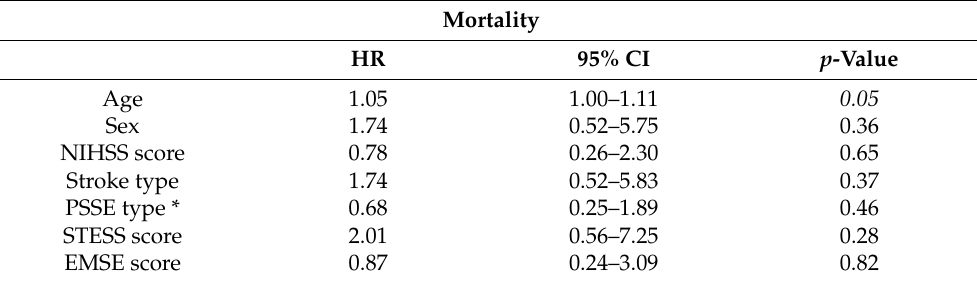
Table 4. Cox Proportional Hazard Regression Model.